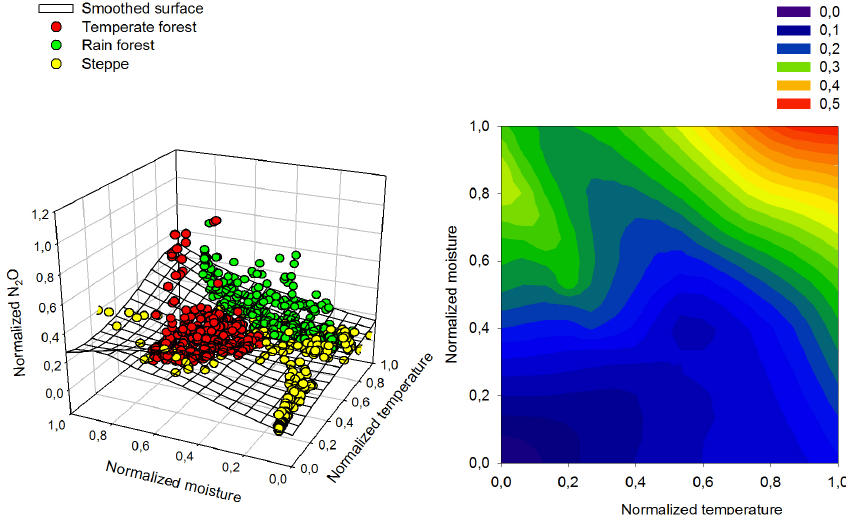
Fig. 9. Temperature and moisture effects on nitrous oxide fluxes (all data) across all three ecosystems (temperate forest, semi-arid steppe, and tropical forest). For this analysis soil moisture and soil temperature as well as nitrous oxide fluxes were first normalized across ecosystems to a range of 0–1 (0: lowest observed value in all ecosystems; 1: highest observed value in all ecosystems). Prior to the calculation of contour lines, data were smoothed with the loess algorithm (sampling proportion = 0.6). Data for temperate forest were randomly selected from observations in the years 1995 and 1997.